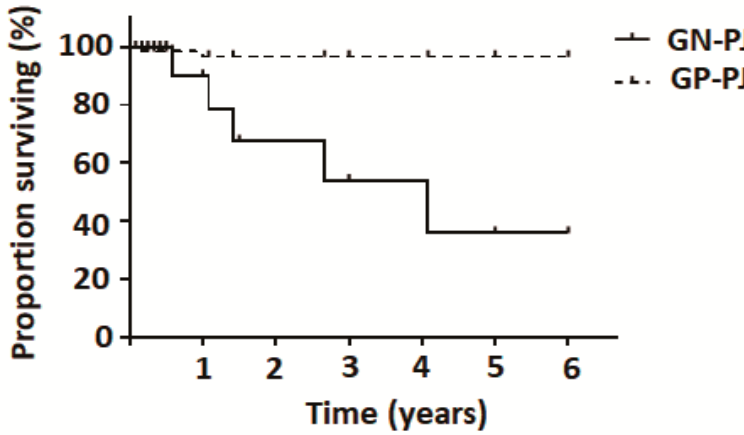
Figure 1. Kaplan–Meier plot of reoperation rates due to aseptic loosening in patients with periprosthetic joint infection caused by Gram-positive ( n = 251) versus Gram-negative ( n = 69) bacteria. The time free from reoperation was significantly lower in the GN-PJI group compared with the GP-PJI group ( p < 0.001).